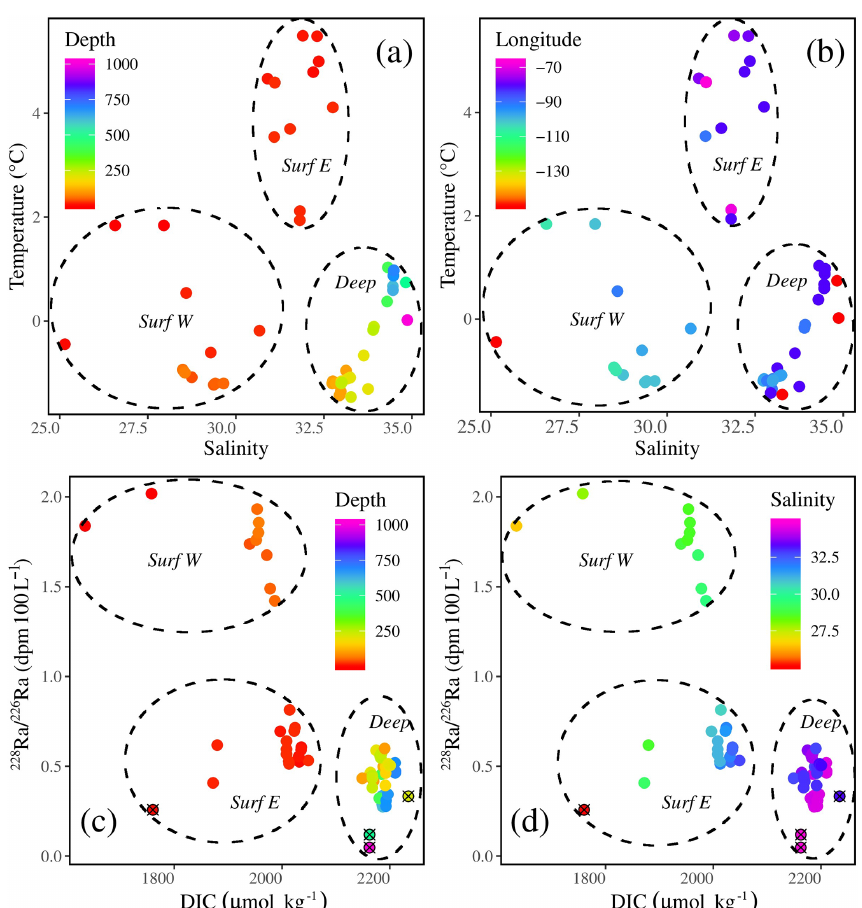
Figure 9. Temperature–salinity plots with the colors indicating (a) depth and (b) longitude. Radium isotopic ratio ( 228 Ra / 226 Ra)–DIC plots with the colors indicating (c) depth and (d) salinity, highlighting three water masses throughout the CAA: the two surface water masses, the western surface (Surf W) and eastern surface (Surf E) waters, and one water mass (Atlantic) at depth (Deep). In panels (c) and (d) , station CB4 has been denoted using a circle and